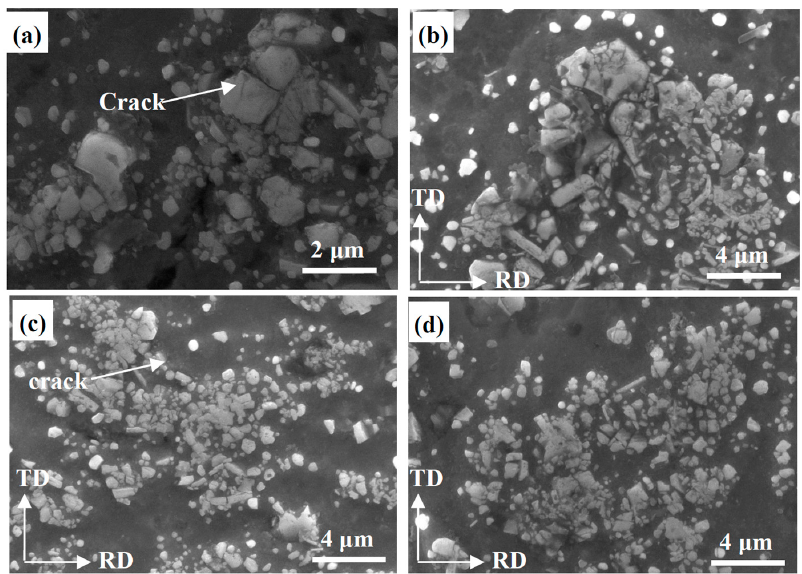
Figure 4. Effect of deformation on the particle distribution of the composites in the RD-TD plane.